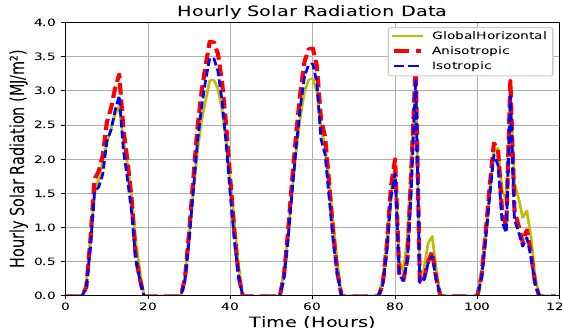
Figure 11. Hourly solar irradiation sums on south facade of the